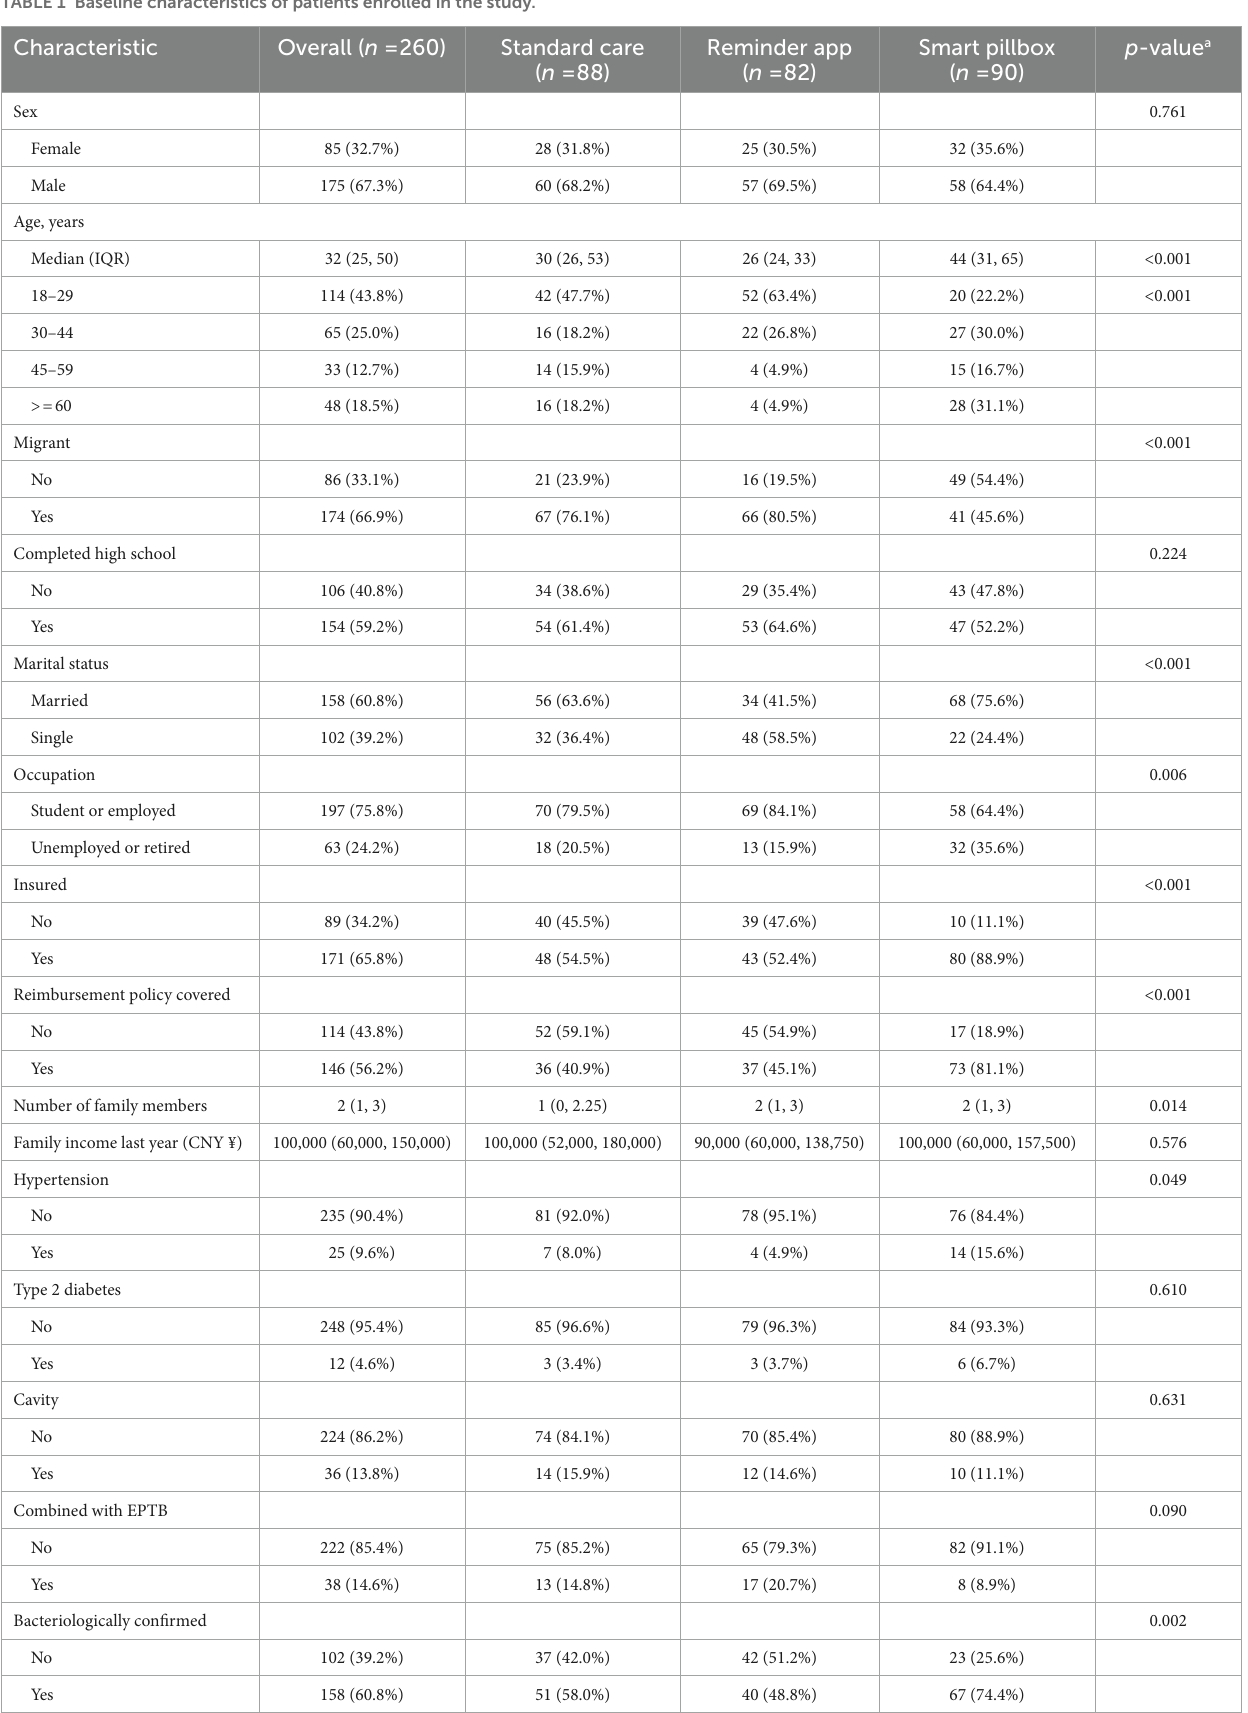
TABLE 1 Baseline characteristics of patients enrolled in the study.